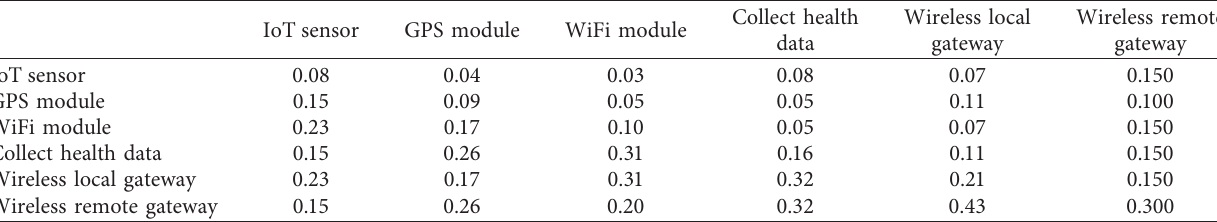
Table 2: Details of the pairwise comparison.